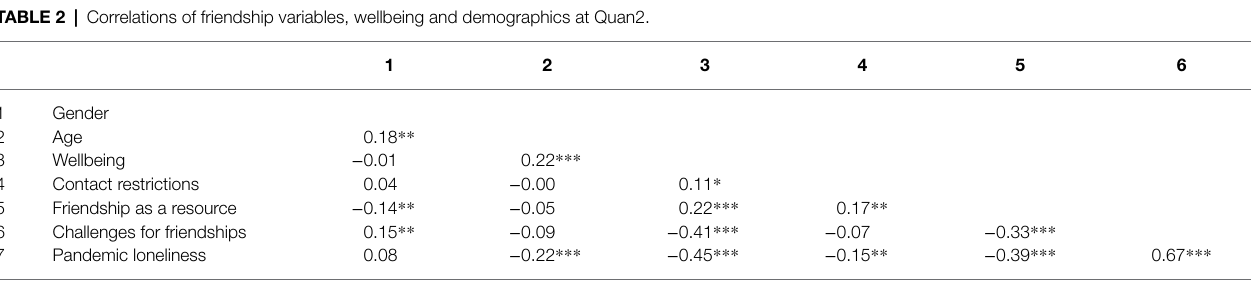
TABLE 2 | Correlations of friendship variables, wellbeing and demographics at Quan2.